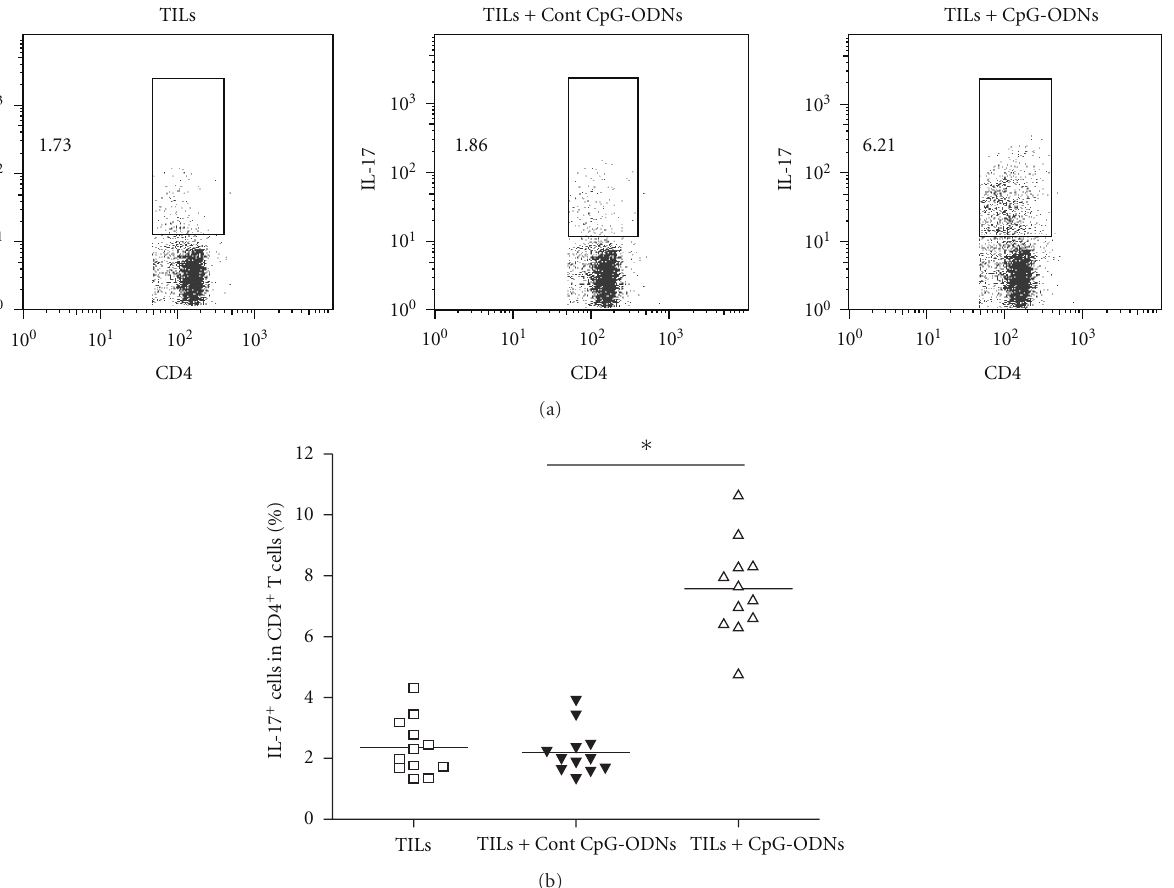
Figure 5: CpG-ODNs enhanced the infiltration of Th17 cells in tumor mass. TILs were collected from lung cancer patients ( n = 12) and treated with CpG-ODNs or control CpG-ODNs as described in Materials and Methods . 1 × 10 7 autologous TILs were transferred into the tumor bearing Balb/c nude mice with 100ug CpG-ODNs or control CpG-ODNs through tail vein. Ten days later, the percentages of IL-17 positive cells in CD4 + T cells isolated from tumor mass were detected by flow cytometry. Representative data from 12 individual patients with lung cancer was shown (a), and the mean frequency of Th17 cells also was calculated, respectively (b). ∗ P < .